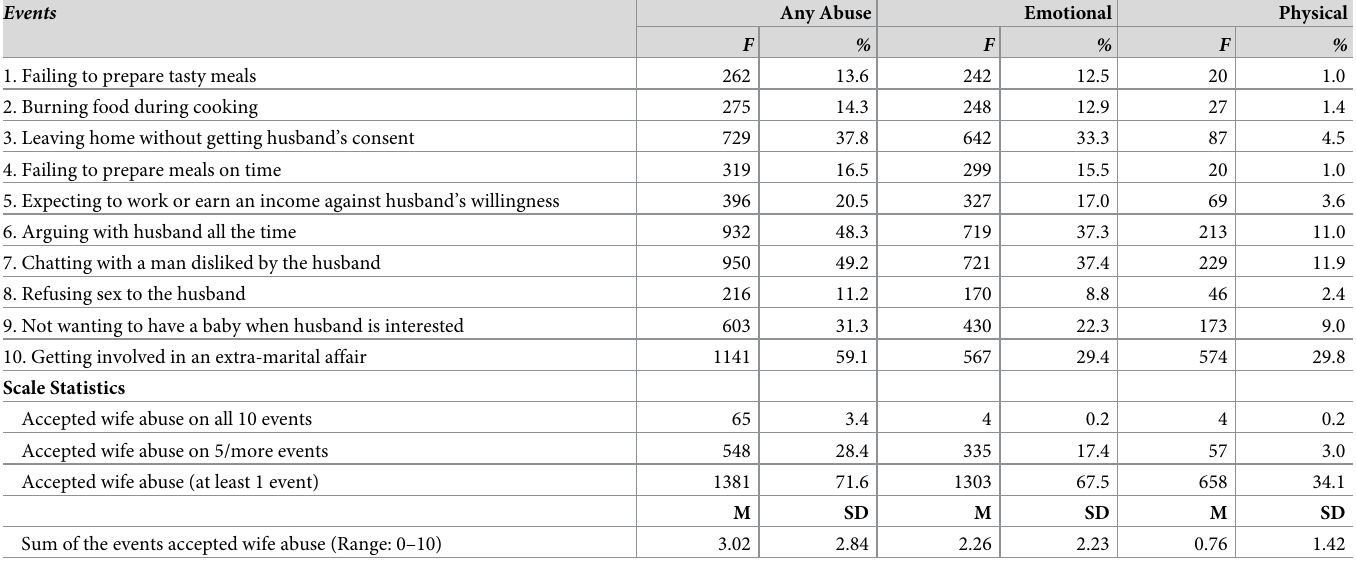
Table 1. Descriptives of the respondents’ attitudinally accepted different wife abuses, N = 1,929. Events Any